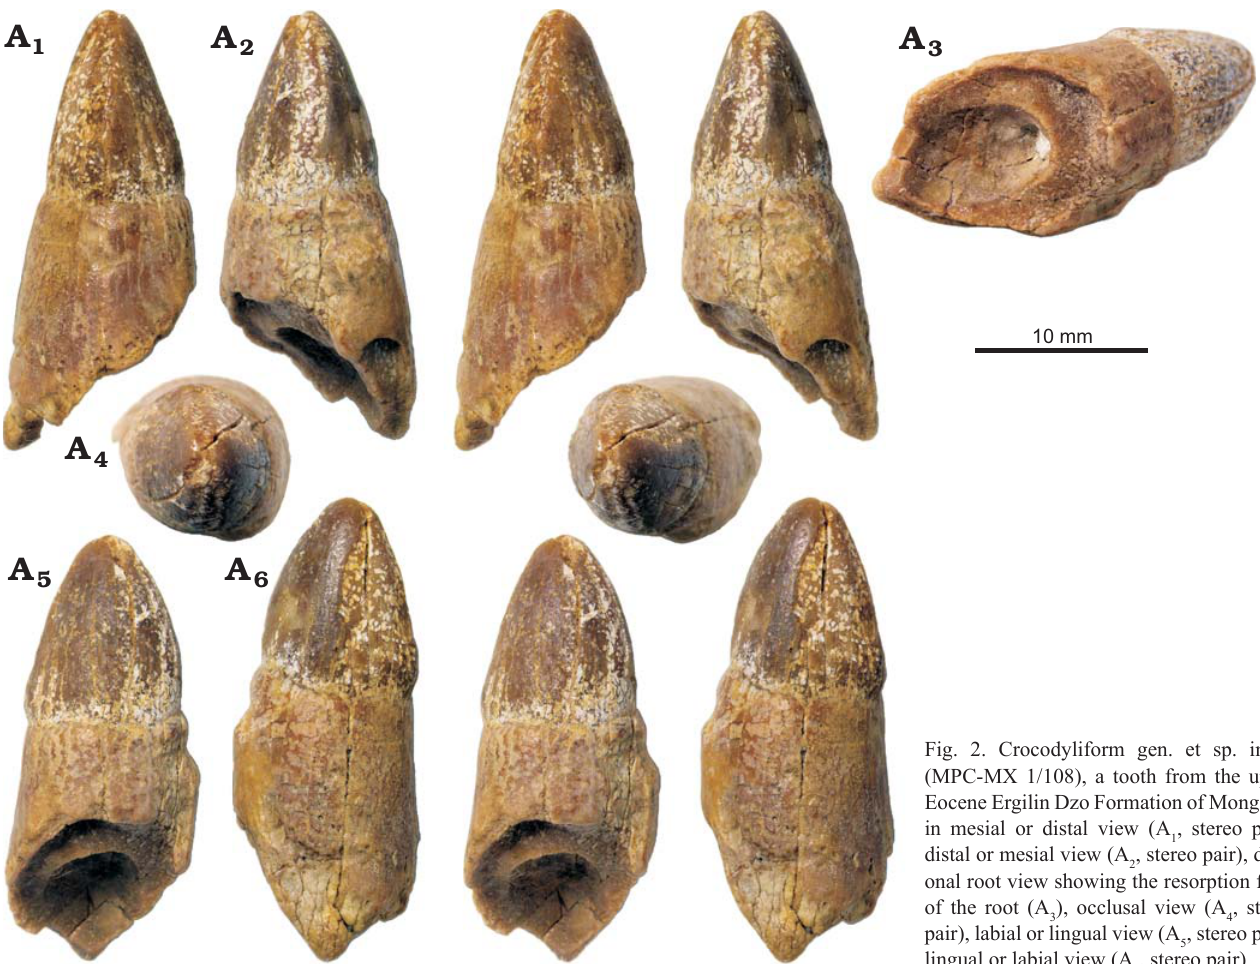
Fig. 2. Crocodyliform gen. et sp. indet. (MPC-MX 1/108), a tooth from the upper Eocene Ergilin Dzo Formation of Mon golia; , stereo pair), in mesial or distal view (A 1 , stereo pair), diag- distal or mesial view (A 2 onal root view showing the resorption facet ), occlusal view (A , stereo of the root (A 3 4 , stereo pair), pair), labial or lingual view (A 5 , stereo lingual or labial view (A 6